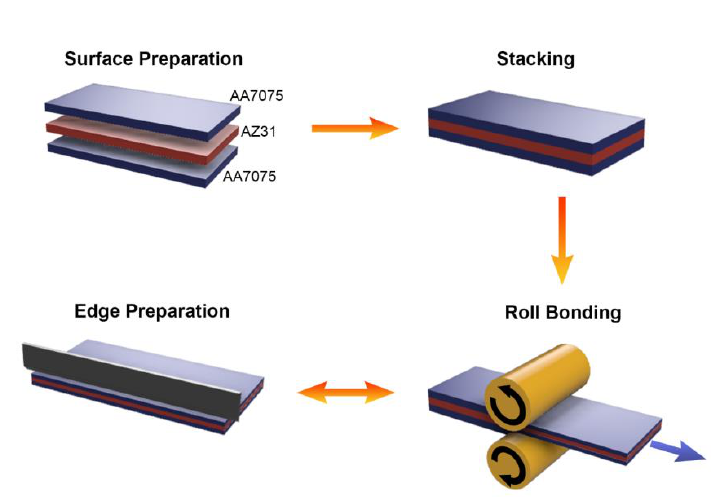
Fig.1. Illustration of ARB process for fabricating the Al-alloy/Mg-alloy/Al-alloy